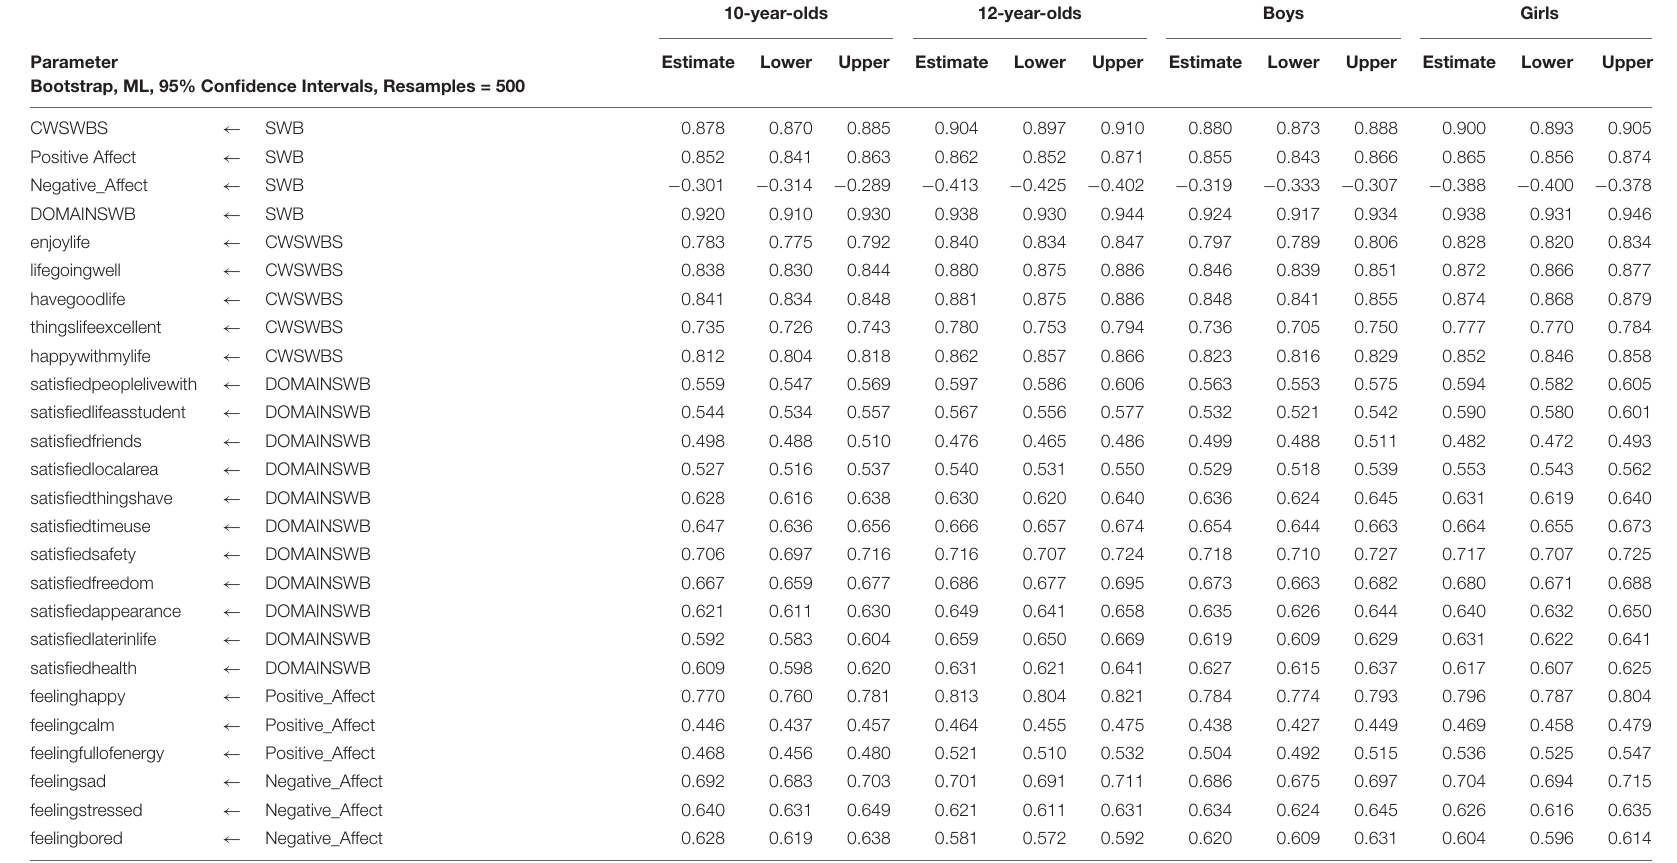
10-year-olds Boys Girls